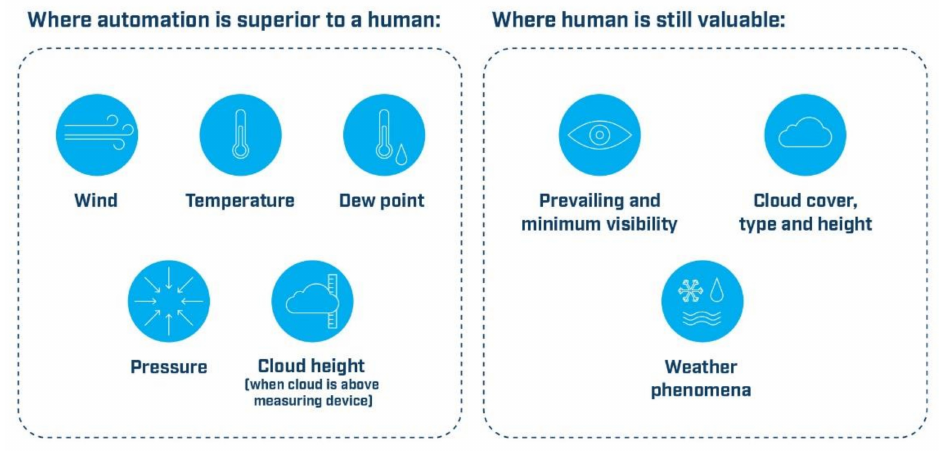
Figure 1. Categorization of the basic meteorological variables to those easily replaceable by automati- zation ( left panel ) and to those where human observers are still highly valuable ( right panel